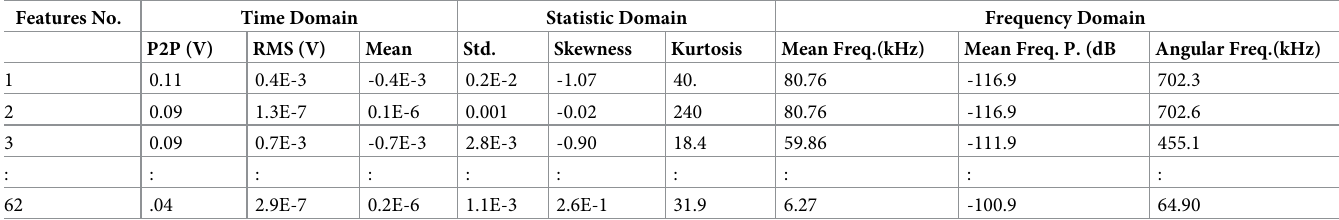
Table 3. An example of AE features set of three domains for single region. Features No.